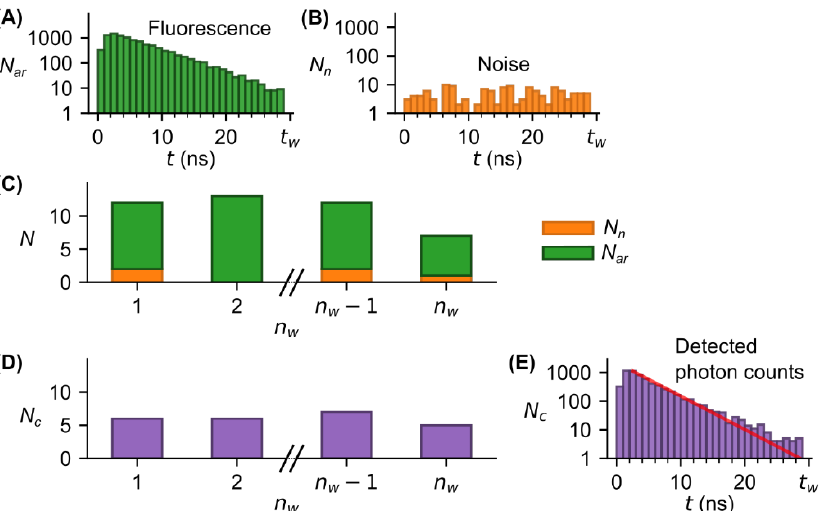
Figure 5. Principle of FL Monte Carlo simulation. ( A ) Distribution of fluorescence photons 𝑁 𝑎𝑟 arriving at the detector. The distribution was obtained by convolving the turn-off function of the laser pulse and the exponential fluorescence decay of the fluorophore. ( B ) Distribution of events that arise from noise sources such as dark counts and scattered light. ( C ) Number of arrived photons per measurement window (randomly Poisson distributed over all measurement windows). ( D ) Number of detected photons per measurement window. Since only one photon can be detected per pixel and measurement window, only the fastest photons are detected. ( E ) Distribution of all detected photons from that the FL is determined by LS fitting.